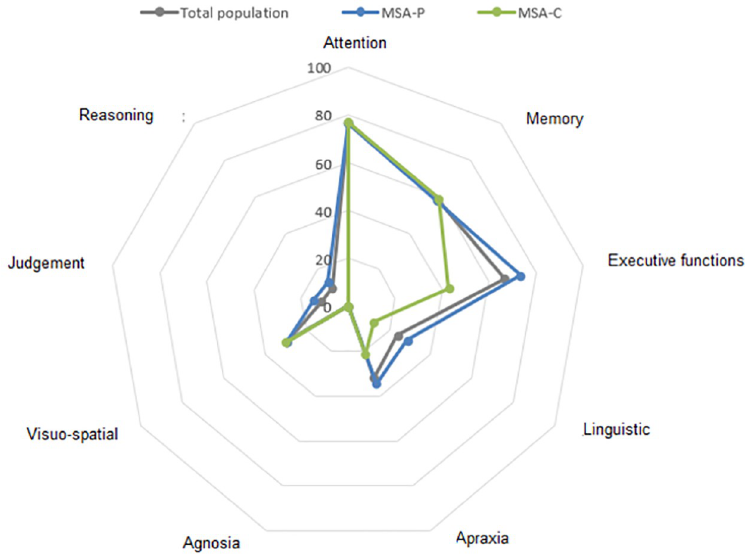
Fig 1. Comparison of altered cognitive domains in multiple system atrophy according to motor subtype (MSA-P vs MSA-C and total study cohort). Radar charts comparing the percentage (%) of AMS-C and AMS-P cases with neurophysiological findings.